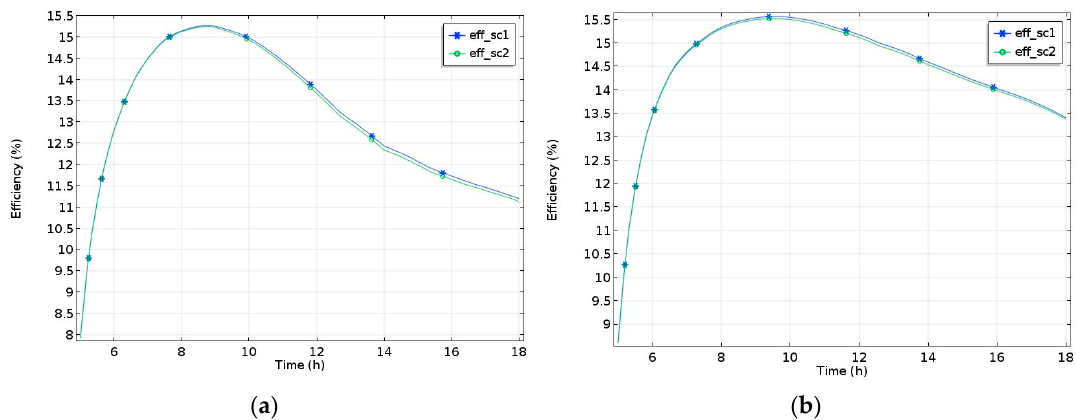
Figure 13. Efficiency of the solar cells over time: ( a ) covered CPC system (17 July 2017); ( b ) uncovered CPC system (18 July 2017).